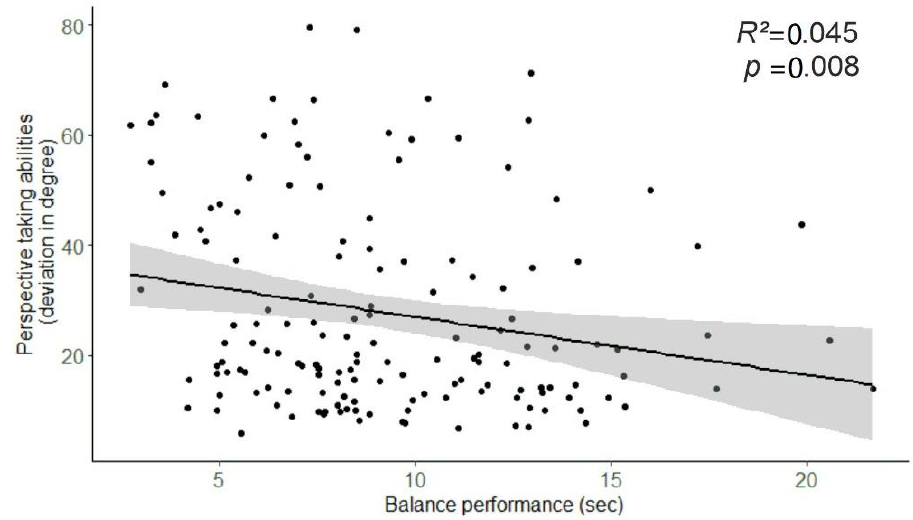
Figure 4. Correlation between balance performance in the eyes-open condition (seconds in correct position) and perspective-taking skills (OPT task, mean deviation error in degree). Confidence bands indicate 95% confidence intervals. Table 2. Hierarchical regression model for perspective-taking abilities (OPT task).